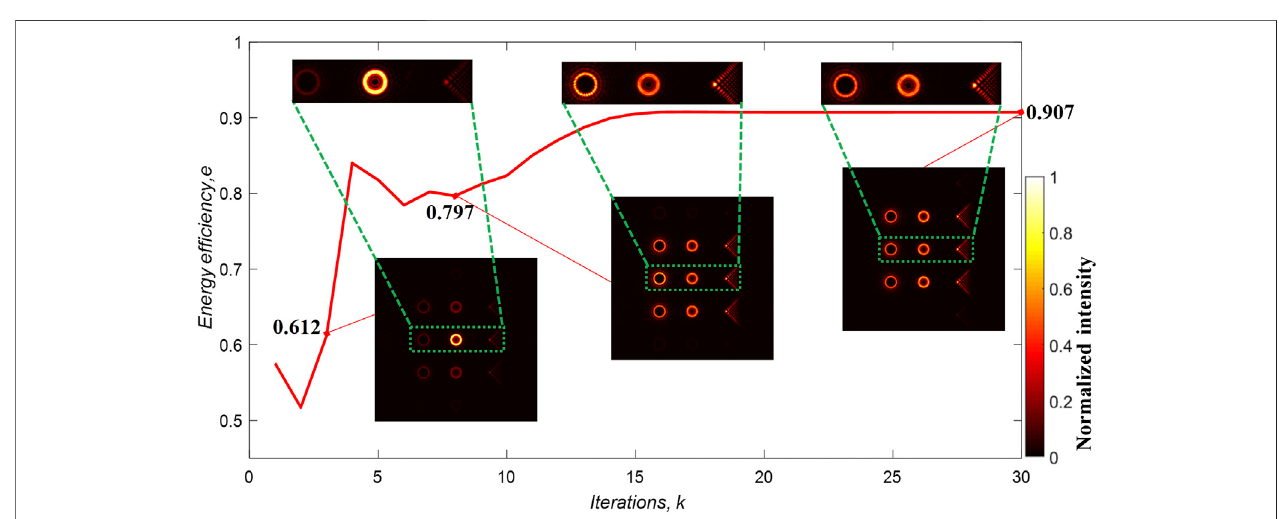
FIGURE 6 | The behavior of energy ef fi ciency is shown as a function ofthe number of iterations. After 3, 8, and 30 iterations, the energy ef fi ciency becomes 0.612, 0.797, and 0.907, respectively. In the bottom insets, the fi rst to third columns of each one are OVs with l (cid:1) +15, PVs with l (cid:1) +5, and Airy beams, respectively.